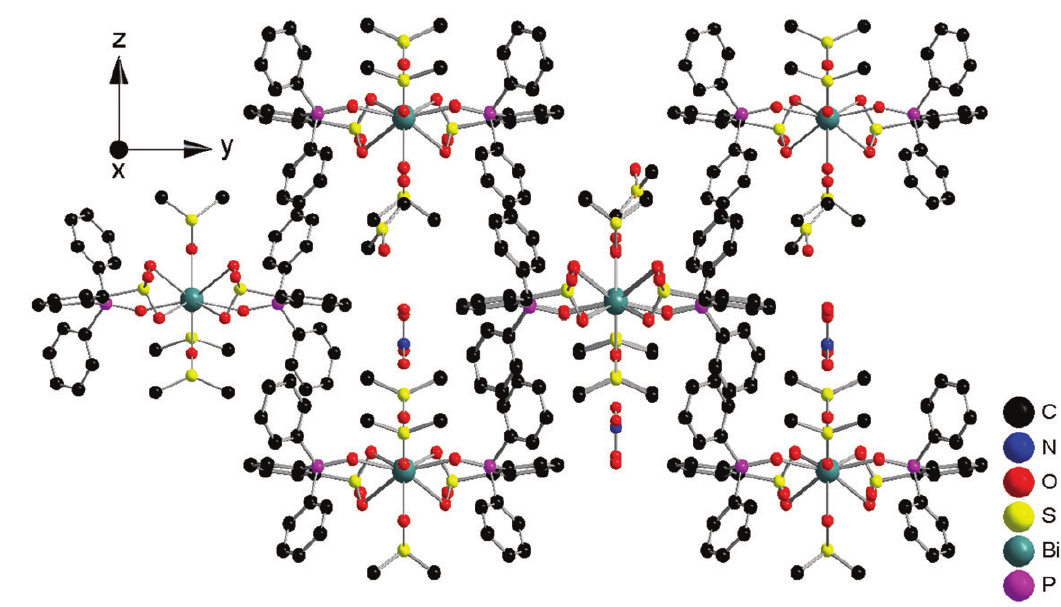
Figure 3 View along [100]-axis of [Bi(C